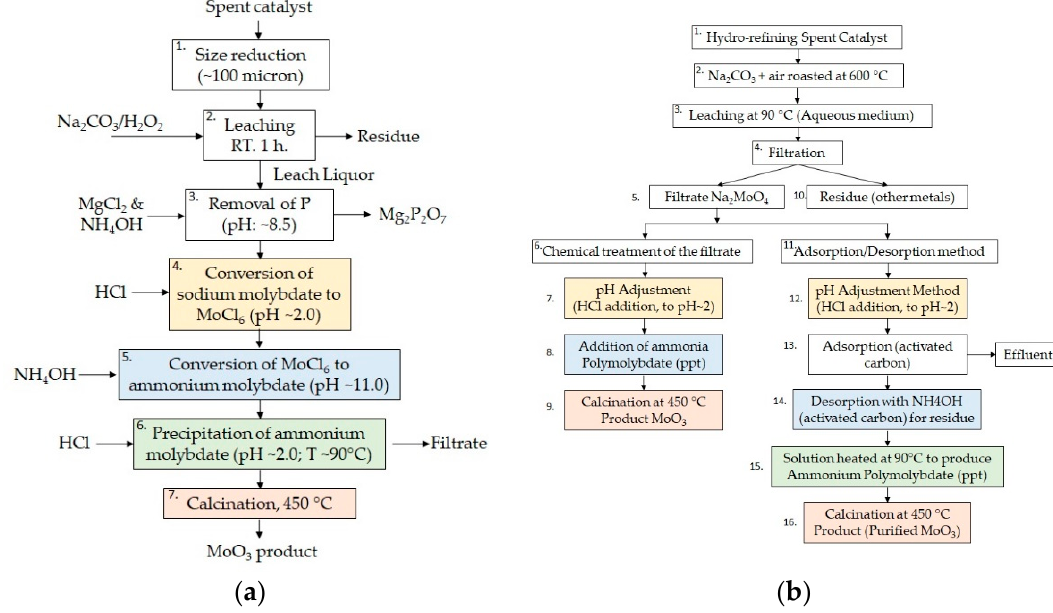
Figure 3. MoO 3 recovery as regeneration of a spent catalyst described by Park [18] ( a ) and Kar [19] ( b ).